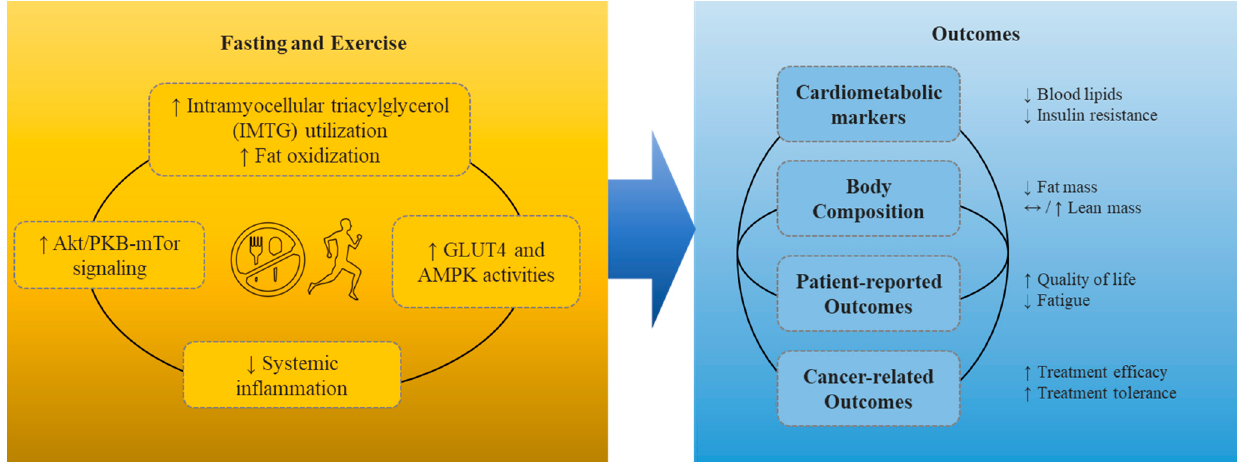
Figure 1. Potential mechanisms and impacts of combined fasting and exercise in cancer patients. Up arrow refers to an increase in the component, down arrow refers to a decrease, and the side ways arros refer to no change.